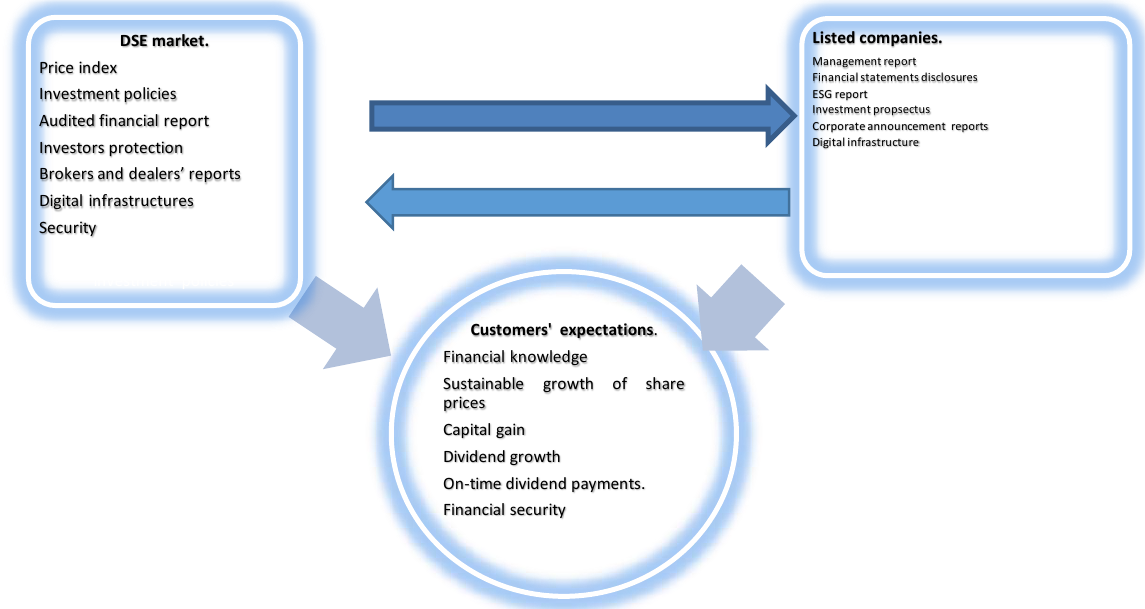
Figure 1: The Conceptual Framework; Source: Researchers